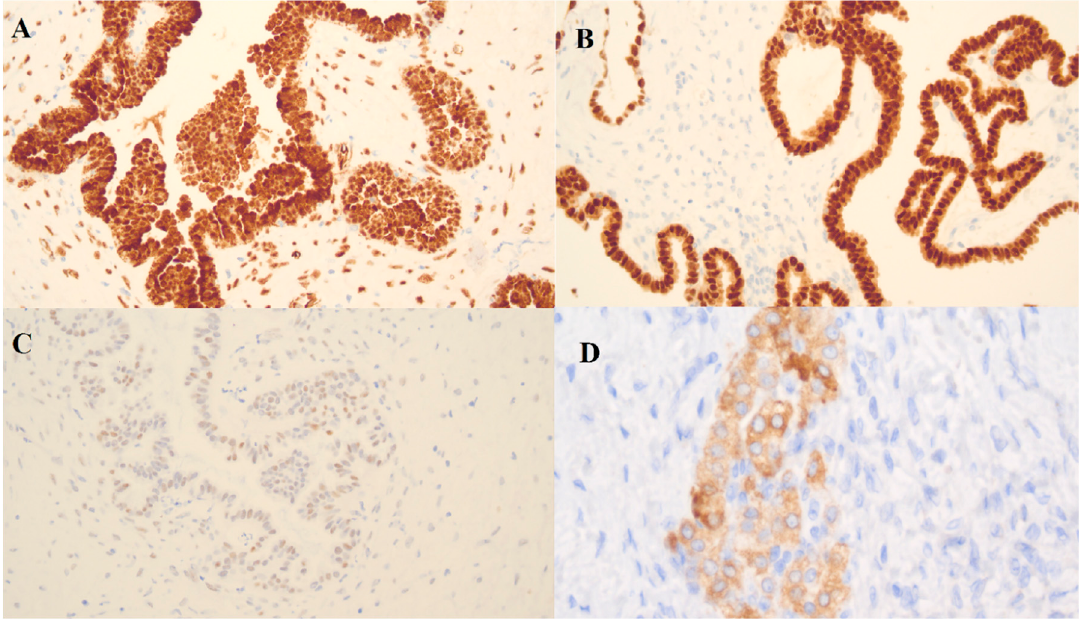
Figure 5. Immunohistochemistry (IHC) detection of (A) WT-1, (B) PAX-8, (C) p53 in a borderline ovarian tumor sample and (D) inhibin alpha in an ovarian fibrothecoma sample.